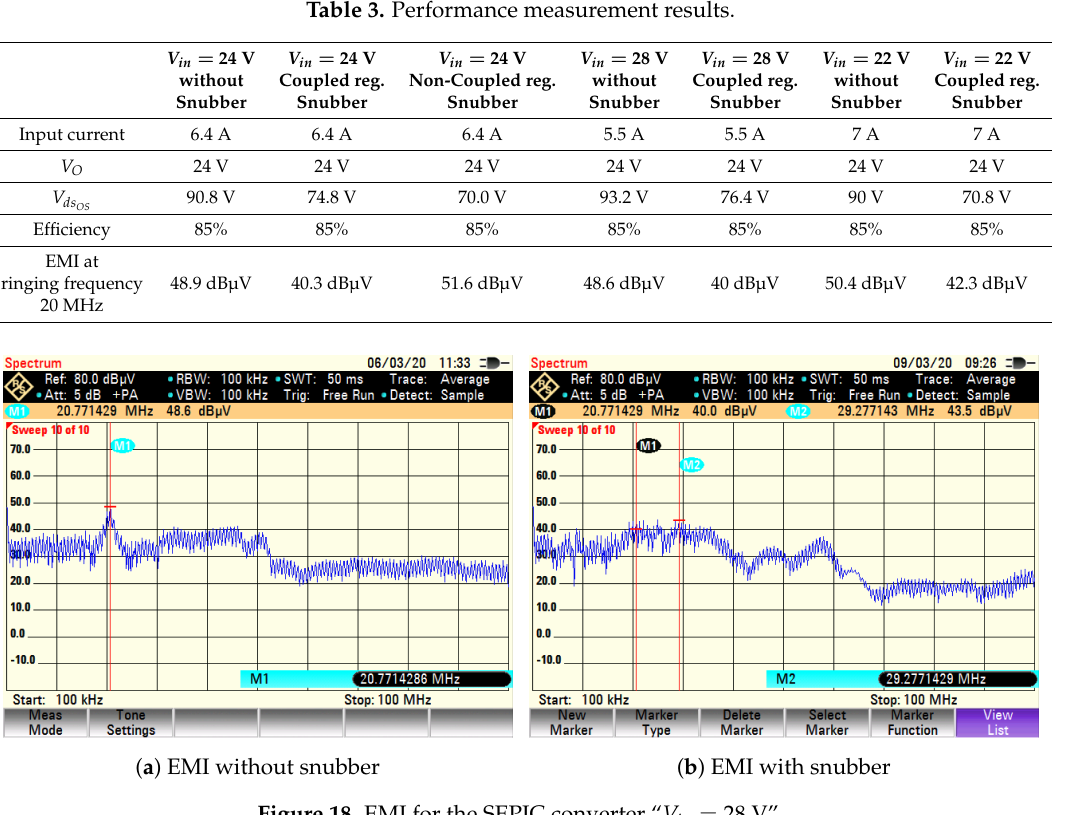
Figure 18. EMI for the SEPIC converter “ V in = 28 V”.